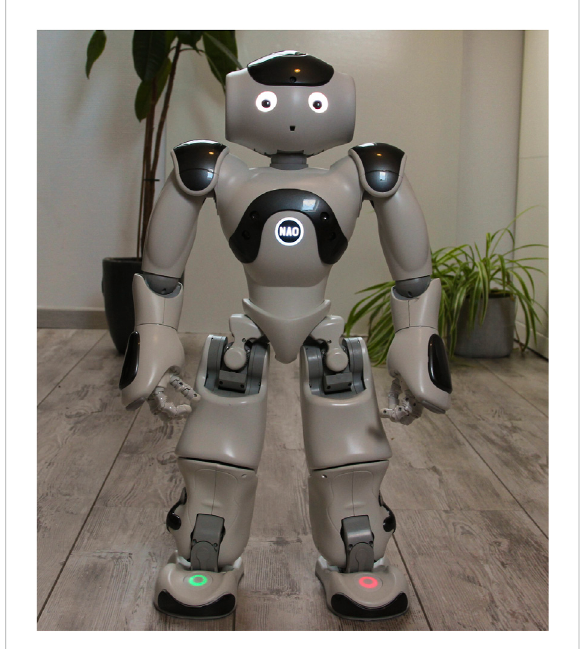
FIGURE 1 The bumper (button) on the robot ’ s foot below the green light means yes and the bumper below the red light means